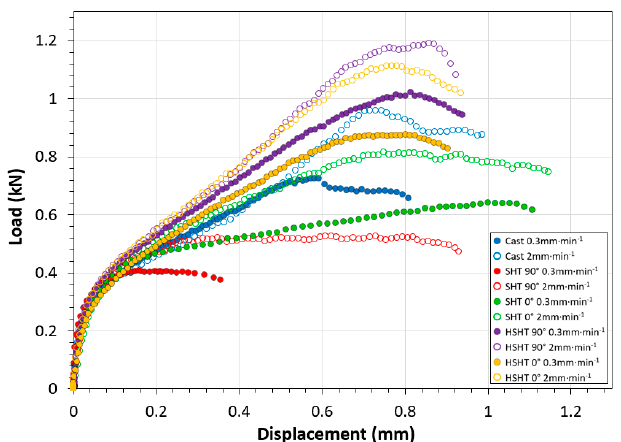
Figure 4. Collation of SPT load-displacement data for all material variants and displacement rates at 780 °C.